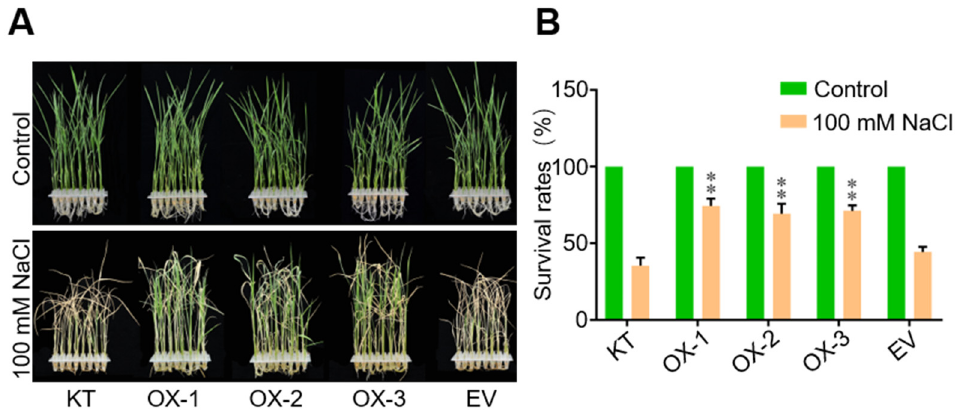
Figure 3. Phenotypes of KT, OX-1, OX-2, OX-3, and EV plants. ( A ) Two-week-old rice seedlings from KT, OX-1, OX-2, OX-3, and EV plants were treated with 100 mM NaCl for seven days and recovered for three days. ( B ) The survival rates under salt stress were measured according to ( A ). Error bars indicate ± SD ( n = 3). ** p -value < 0.01 (Student’s t ‐ test).